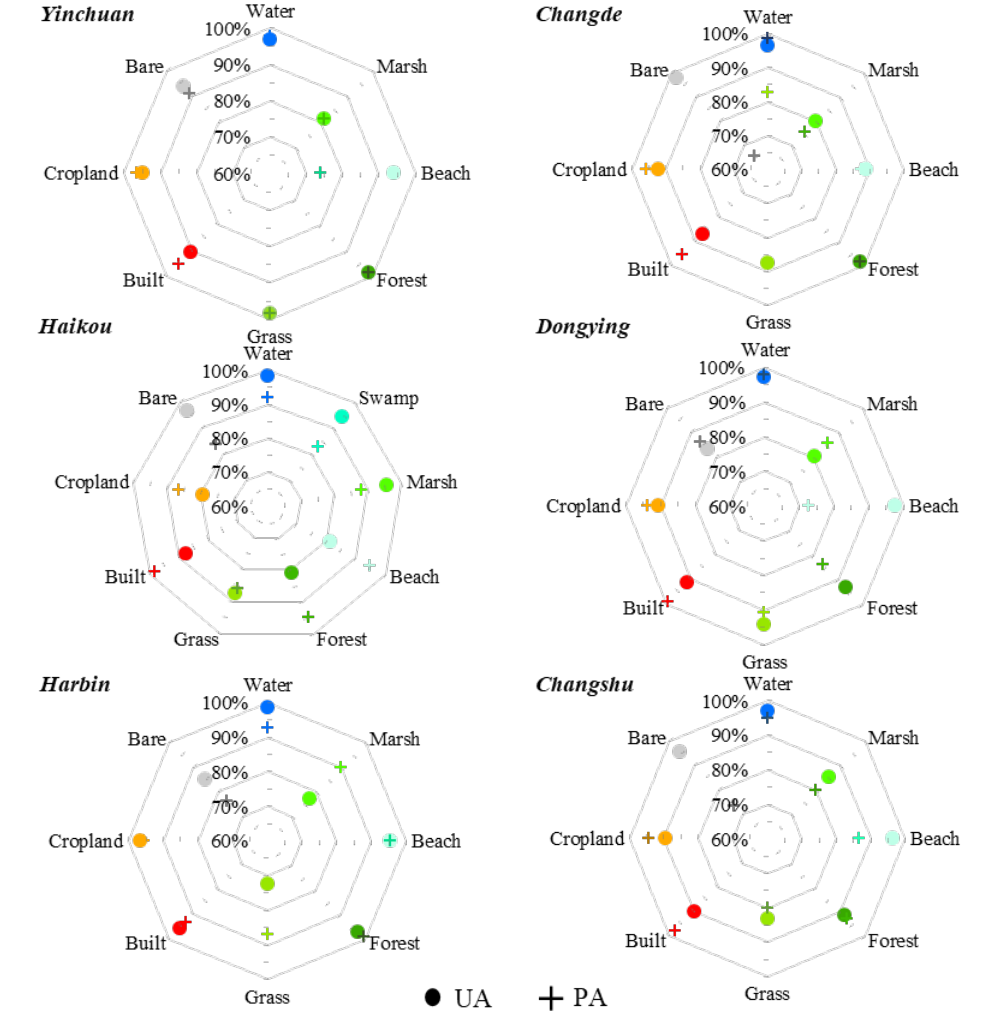
Figure 4. Producer’s accuracy (PA) and user’s accuracy (UA) for land cover types in 6 cities in 2020. A typical area was selected in each of the six cities to compare our land cover results (LC2020) with ESA_ WC10 and DW10 (Figure 5). By comparison with Sentinel-2 images,